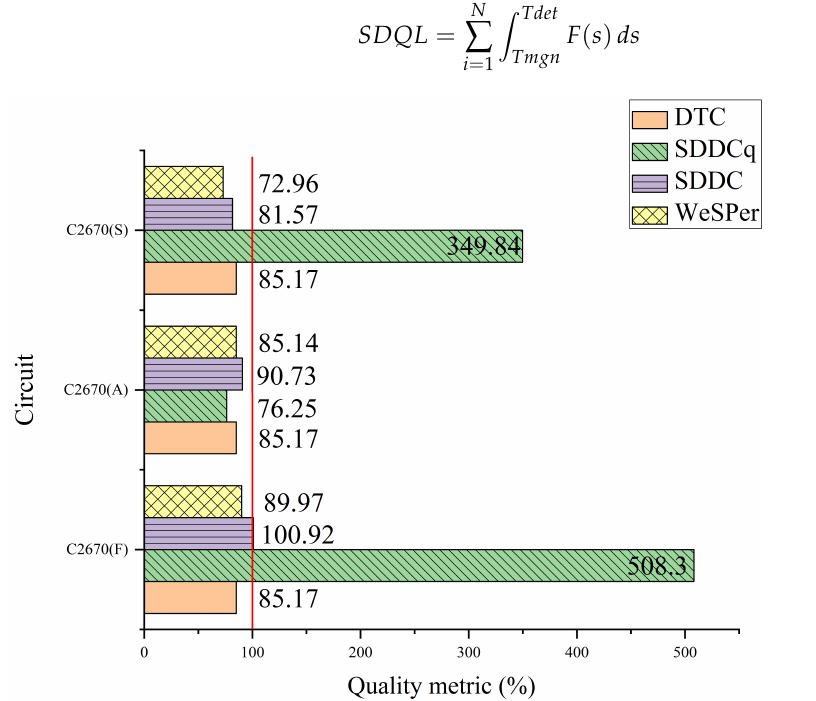
Figure 12. Comparison of different test quality metric at Slow (S), At-speed (A), Fast (F) test clock